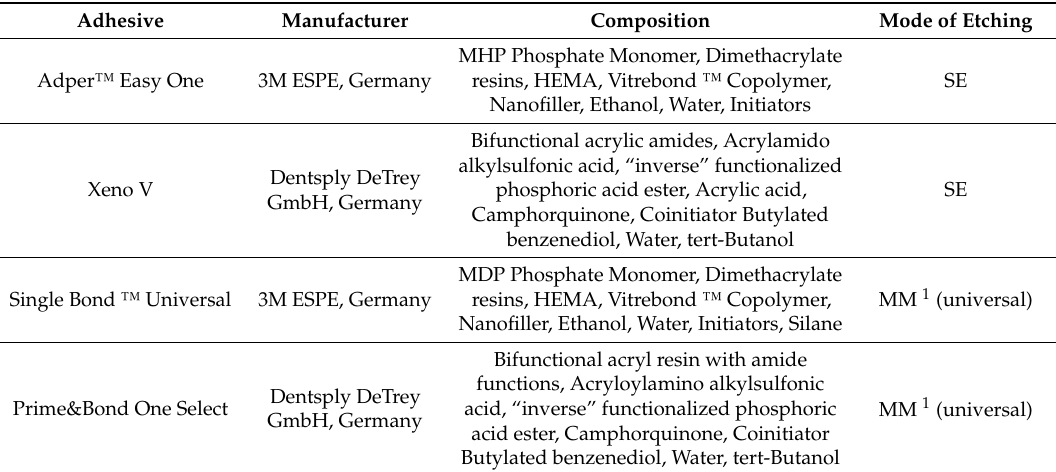
Table 3. Dental adhesives used in the